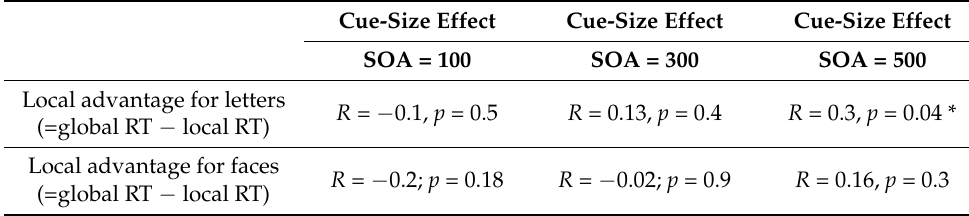
Table 3. Correlational data between the cue-size effect at different SOAs (100, 300, and 500 ms) and the local advantage for letters and faces. Cue-Size Effect Cue-Size Effect Cue-Size Effect SOA = 100 SOA = 300 SOA =